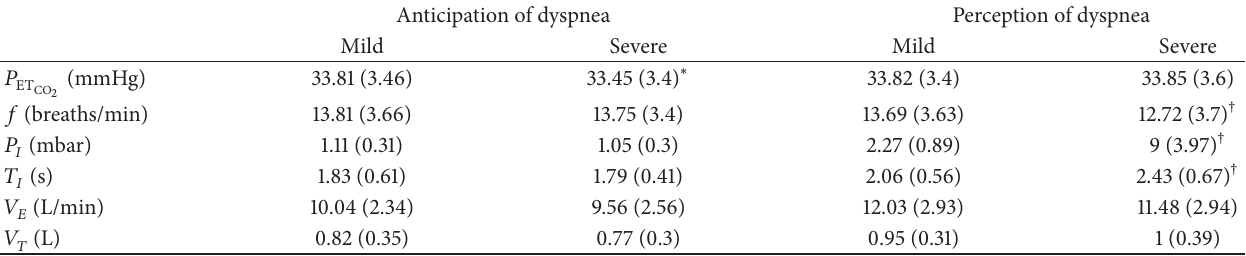
Table 2: Group mean (SD) respiratory parameters for conditions of anticipation and perception of dyspnea.